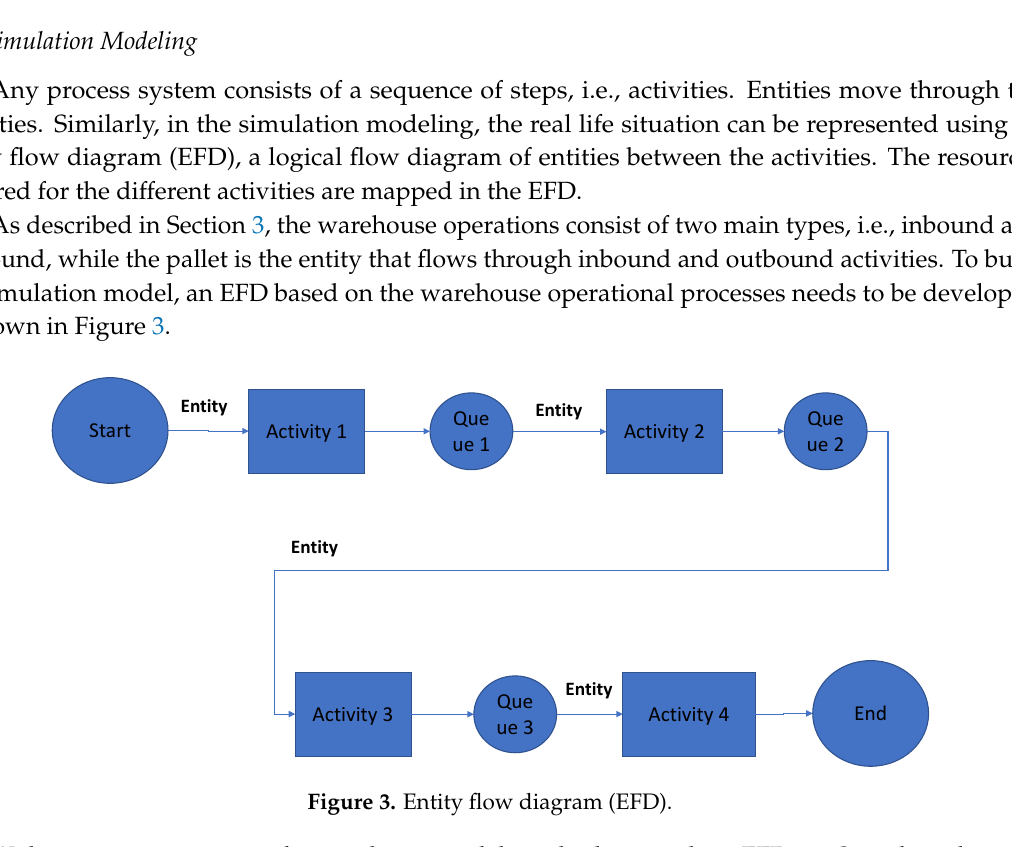
Figure 3. Entity flow diagram